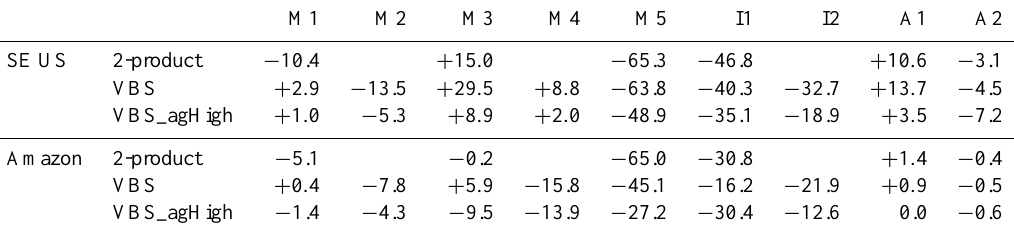
Figure 6. Comparison of surface AMS measurements (units: µgm − 3 ) and three simulations. First column: total OA; second column: SOA(OOA); third column: POA(HOA). The r 2 and rmsd are included in each subplot. The OOA is a surrogate for SOA from all sources. The observed HOA is a surrogate for POA from combustion and biomass burning. Simulated POA is identical in the three simulations. In the POA-HOA comparison, data points with observed HOA smaller than 0.01µgm − 3 have been set to 0.01µgm − 3 to be shown in the plots. Table 6. The relative contributions (%) of each SOA formation pathway to the total SOA concentration change in the southeast US and the . The sums of all numbers in each simulation equal − 100% because the total SOA change in Amazon, defined as SOA change in each pathway | total SOA change | the sensitivity runs compared to the control runs are always negative. The reaction denotations are the same as defined in Fig. 10. M1 M2